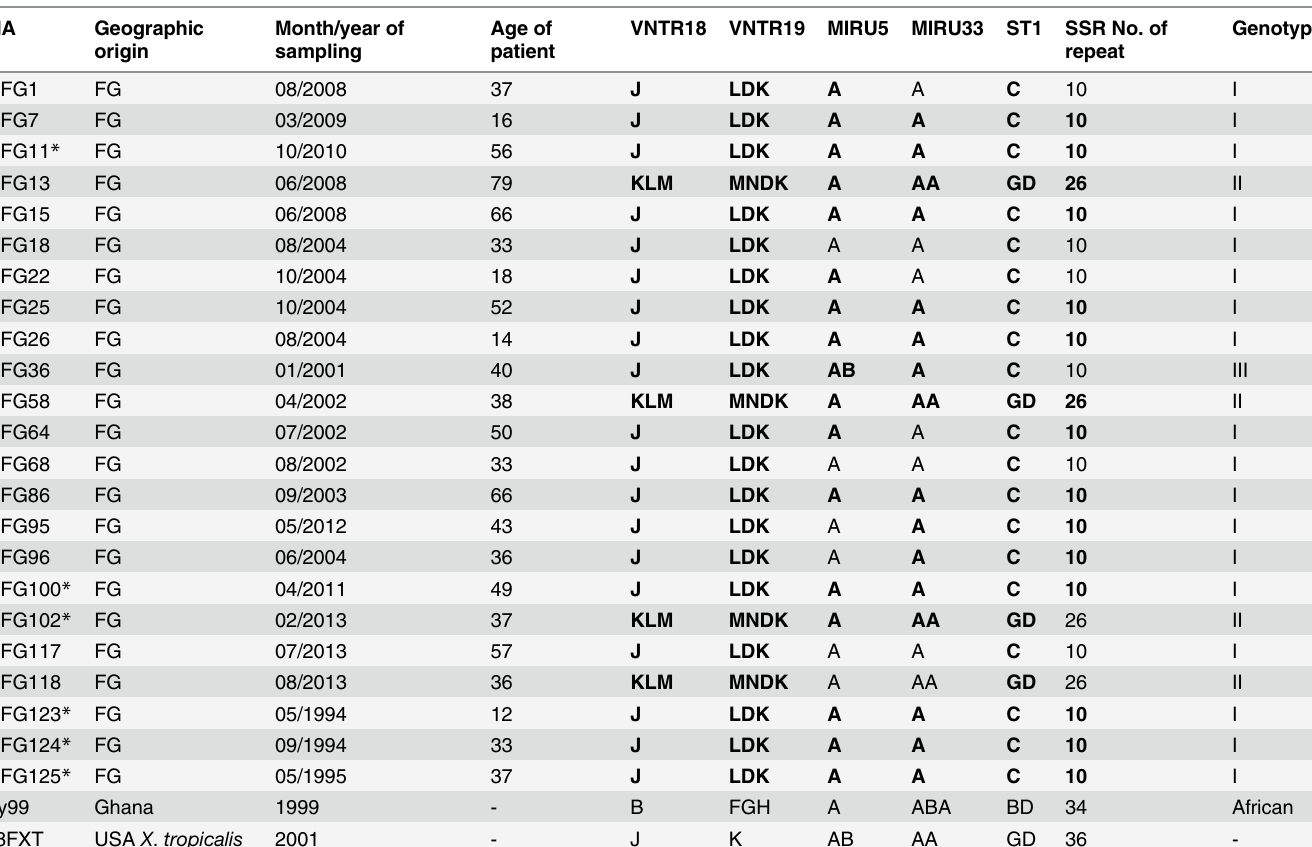
Table 1. Characteristics of M . ulcerans samples used in this study and sequence types based on sequence variations of tandem repeat units. DNA Geographic origin